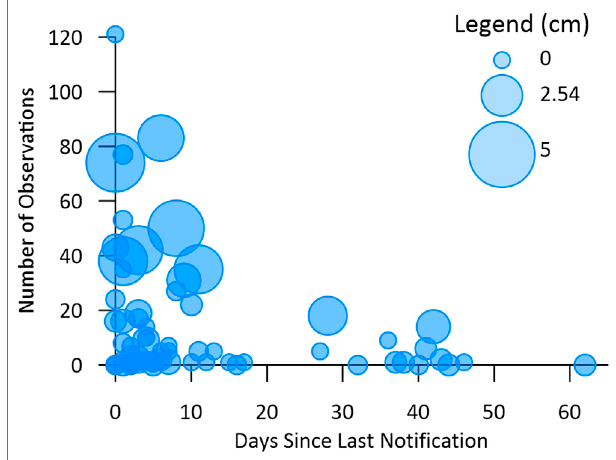
FIGURE 4 | Number of observations per day vs. number of days since last text noti fi cation with the symbol scaled by precipitation accumulation amount from Mount Rose SNOTEL ( Figure 2B ) for that